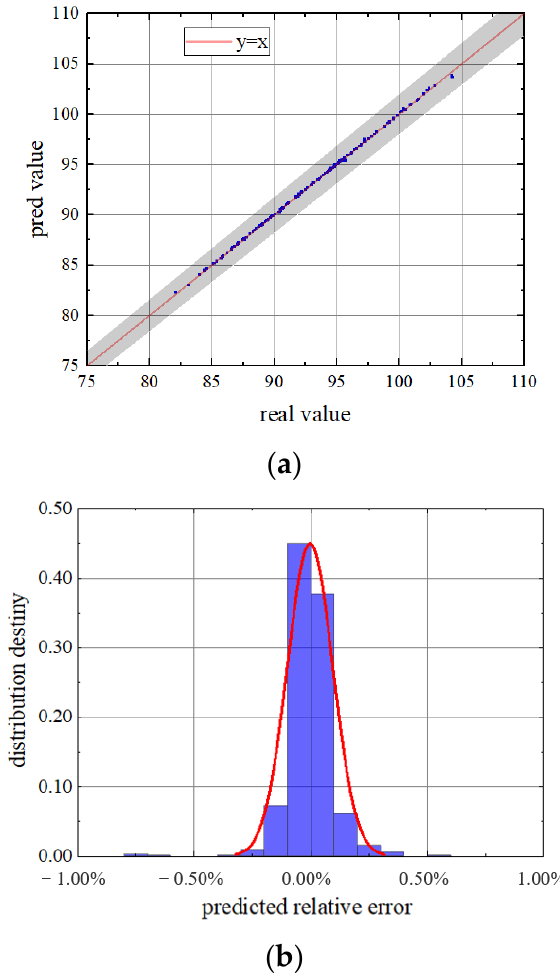
Figure 12. Mean tangential flow force (( a ) Predicted value and true value; ( b ) relative error density distribution).